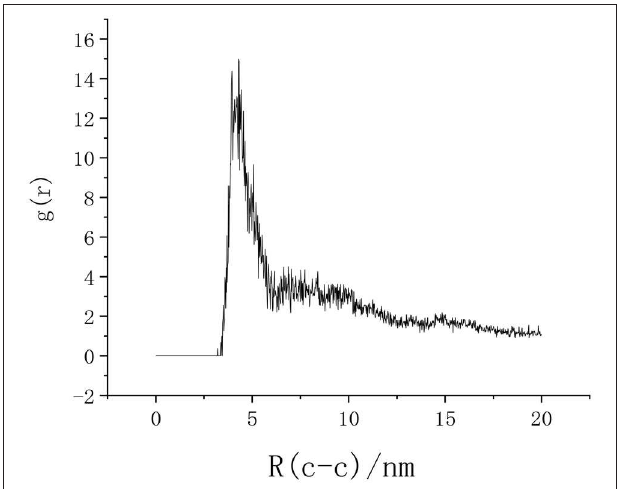
FIGURE 7 | Radial distribution function of the emulsifier end-carbon atoms in the SDBS solution. The obvious characteristic peak indicates that there is adsorption between them.